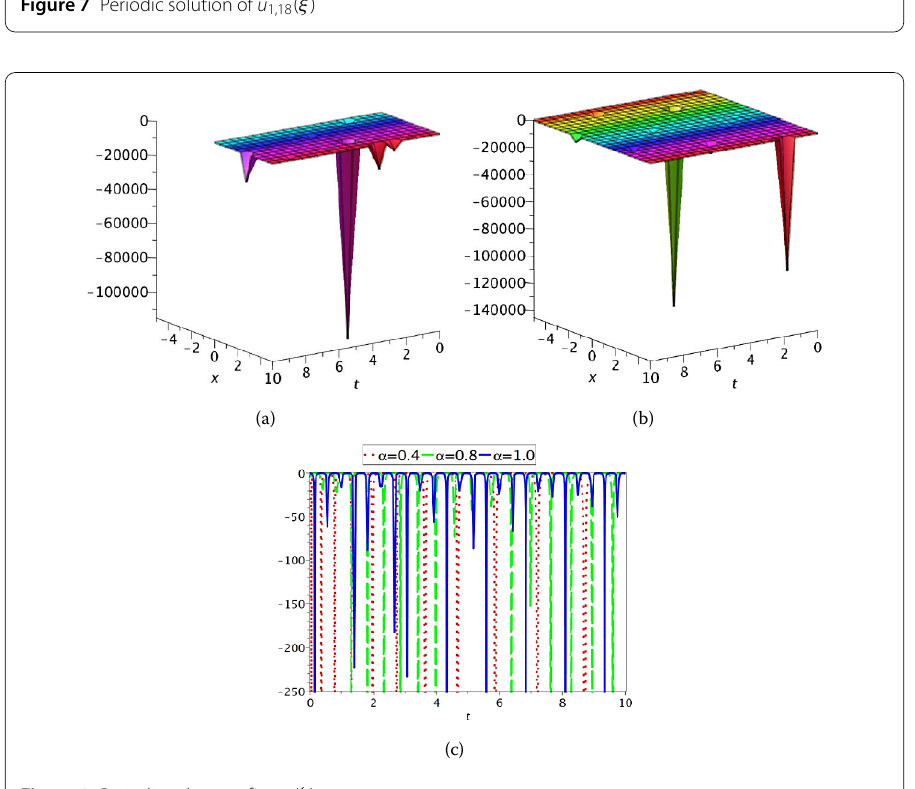
Figure 8 Periodic solution of u 1,19 ( ξ